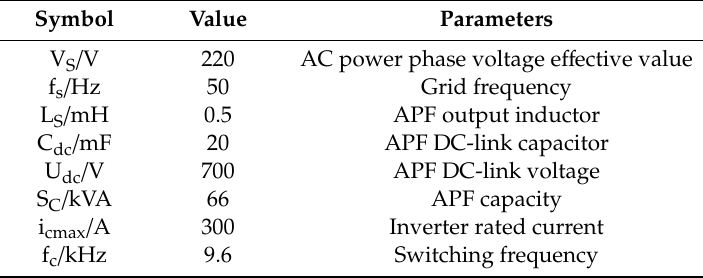
Table 1. Main parameters of the APF system.